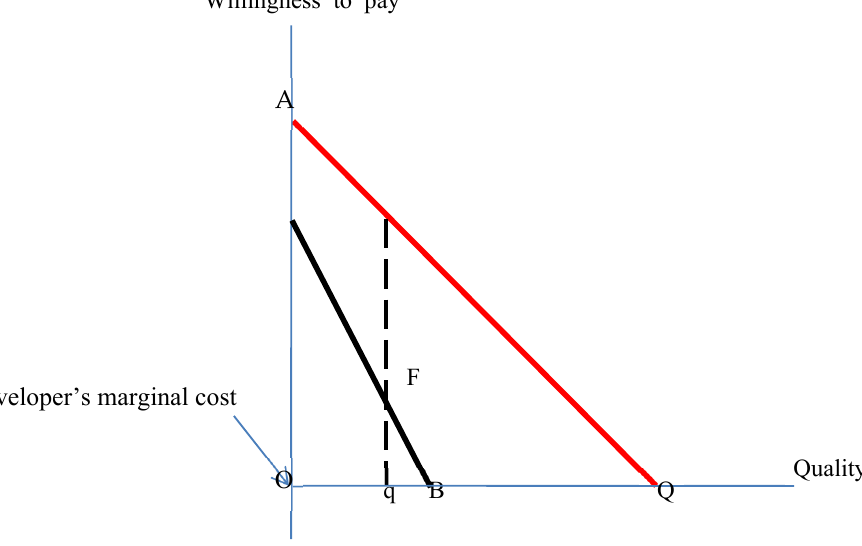
Figure 3. Second-degree price discrimination on the premise of incomplete information.